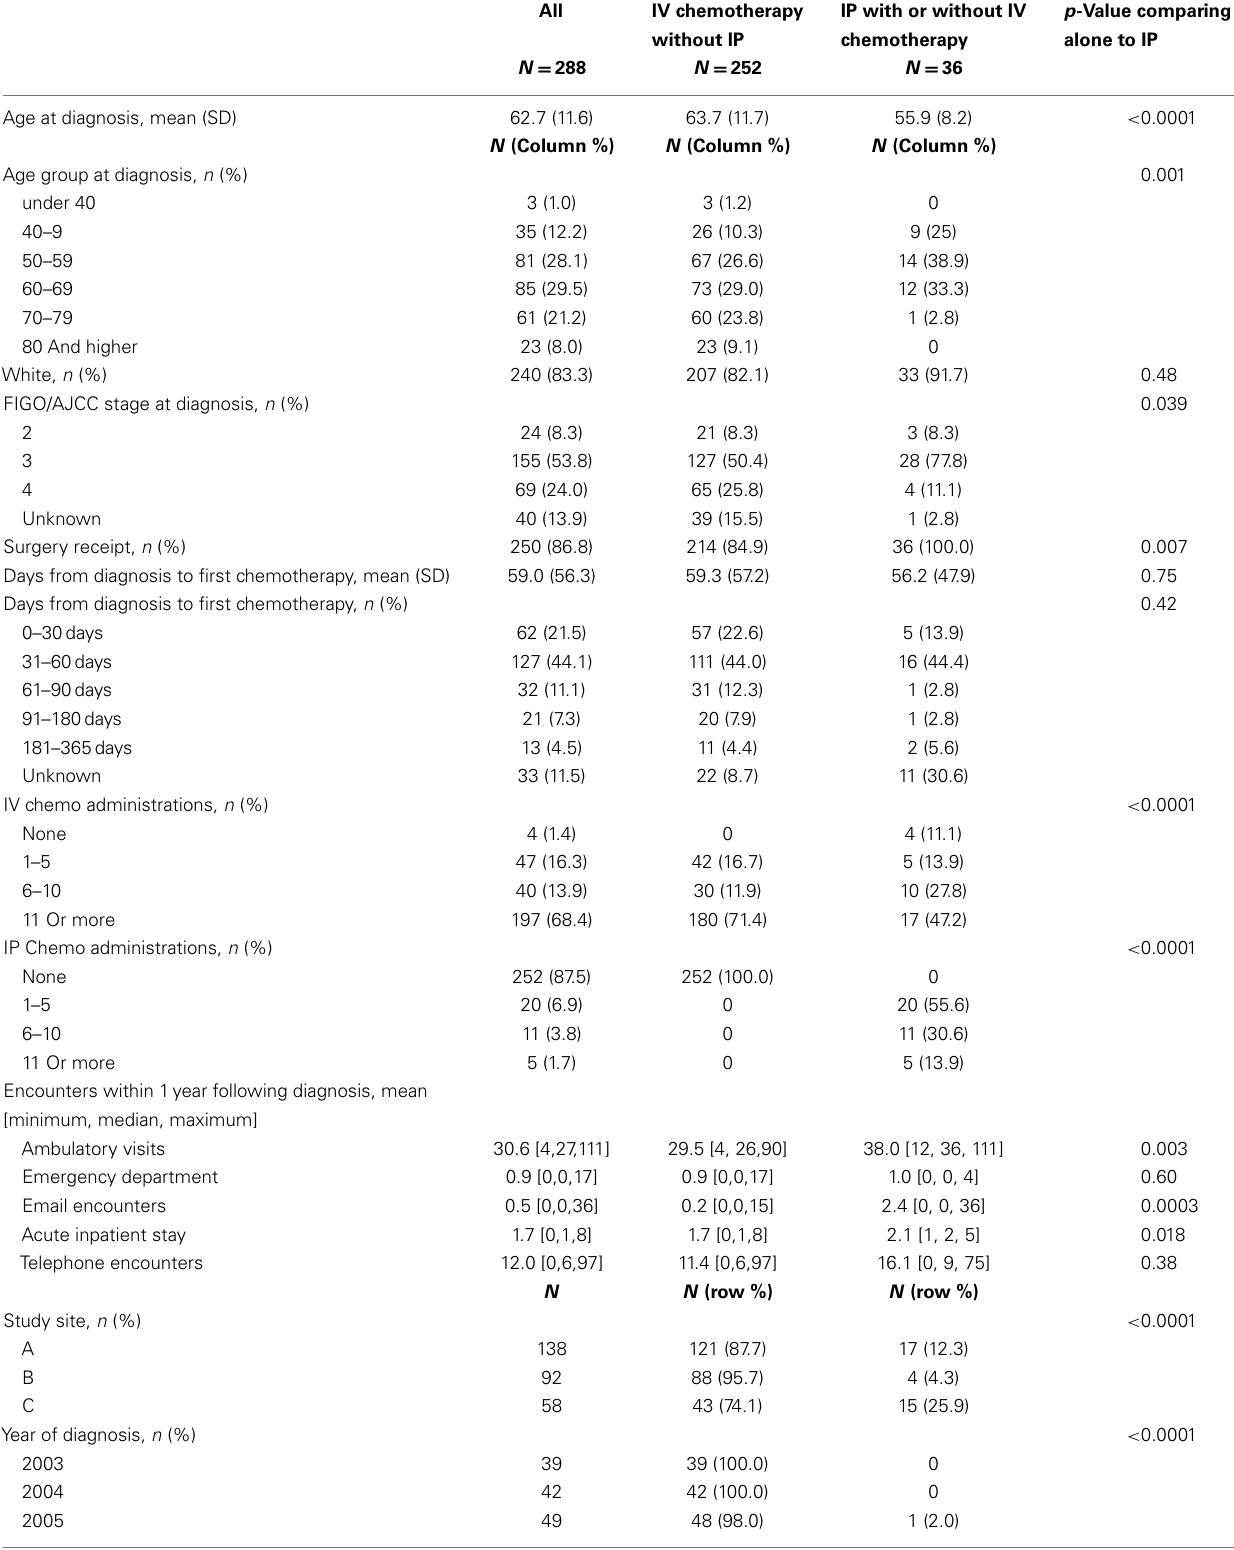
Table 1 | Patient characteristics by IP chemotherapy status